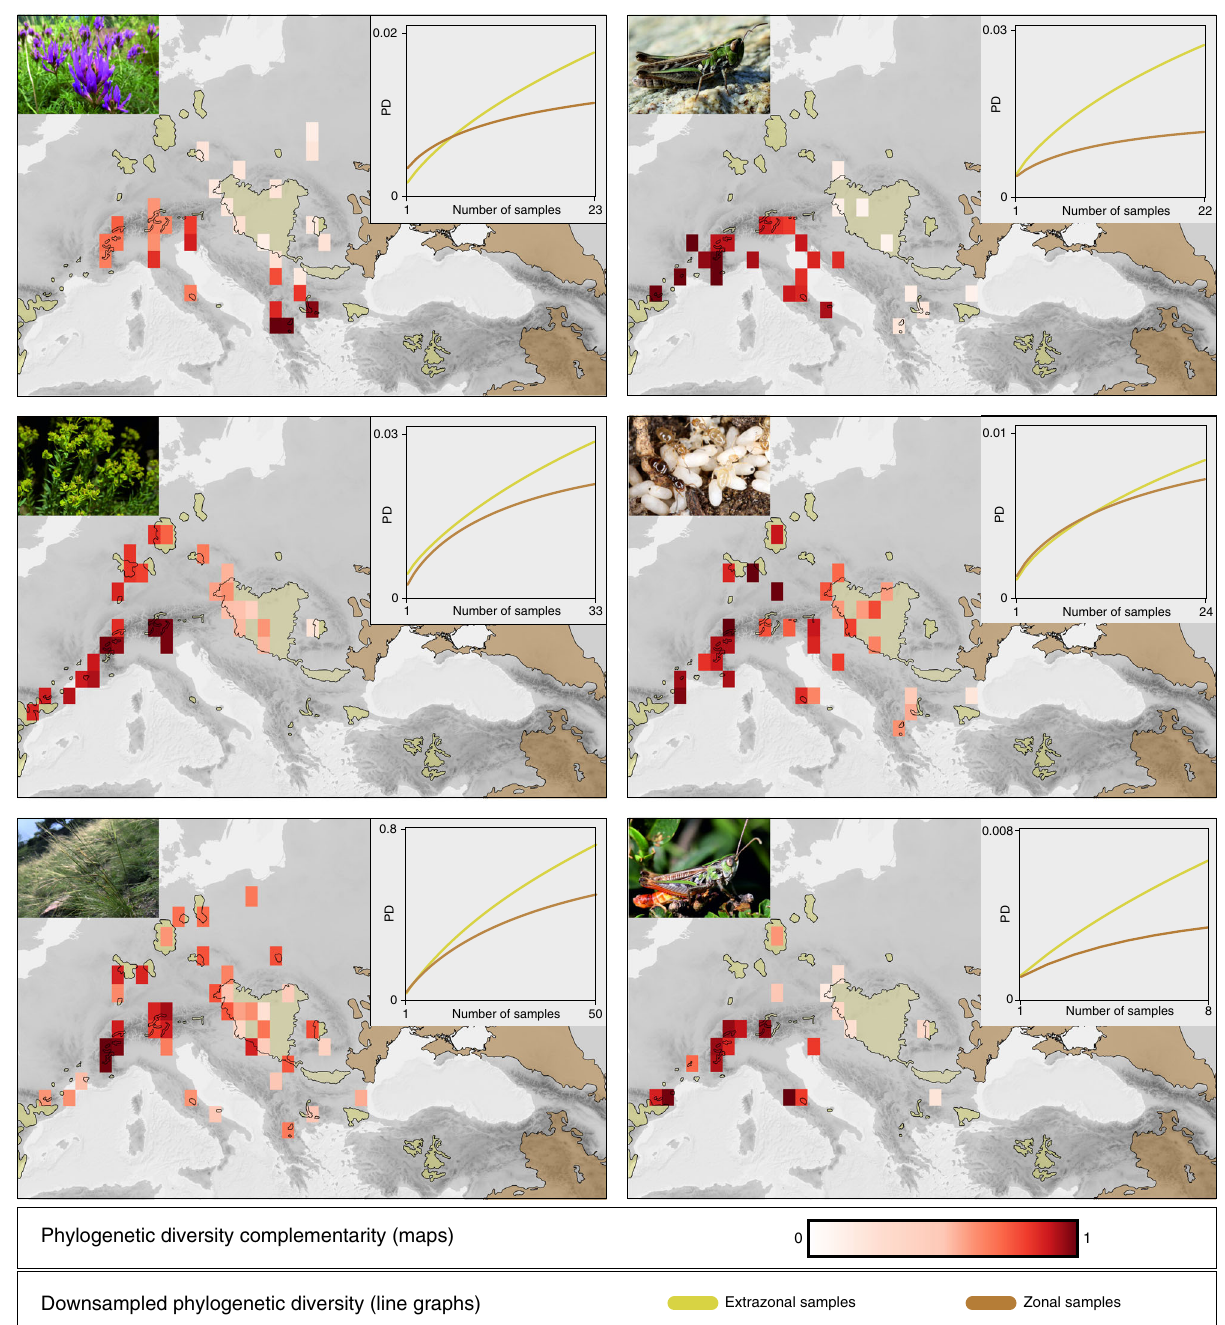
Fig. 4 Distribution of phylogenetic diversity (PD) complementarity and PD in six Eurasian steppe species. Grid cells of an equal edge length of one degree encompass sampled populations. PD complementarity values are shown as colour of heat. Curves in the insets show the rare fi ed PD of extrazonal and zonal populations; the extent of extrazonal and zonal steppes are outlined using the same layers as in Fig. 1a (yellow line: extrazonal steppes, brown line: zonal steppes). Source data are provided as a Source Data fi